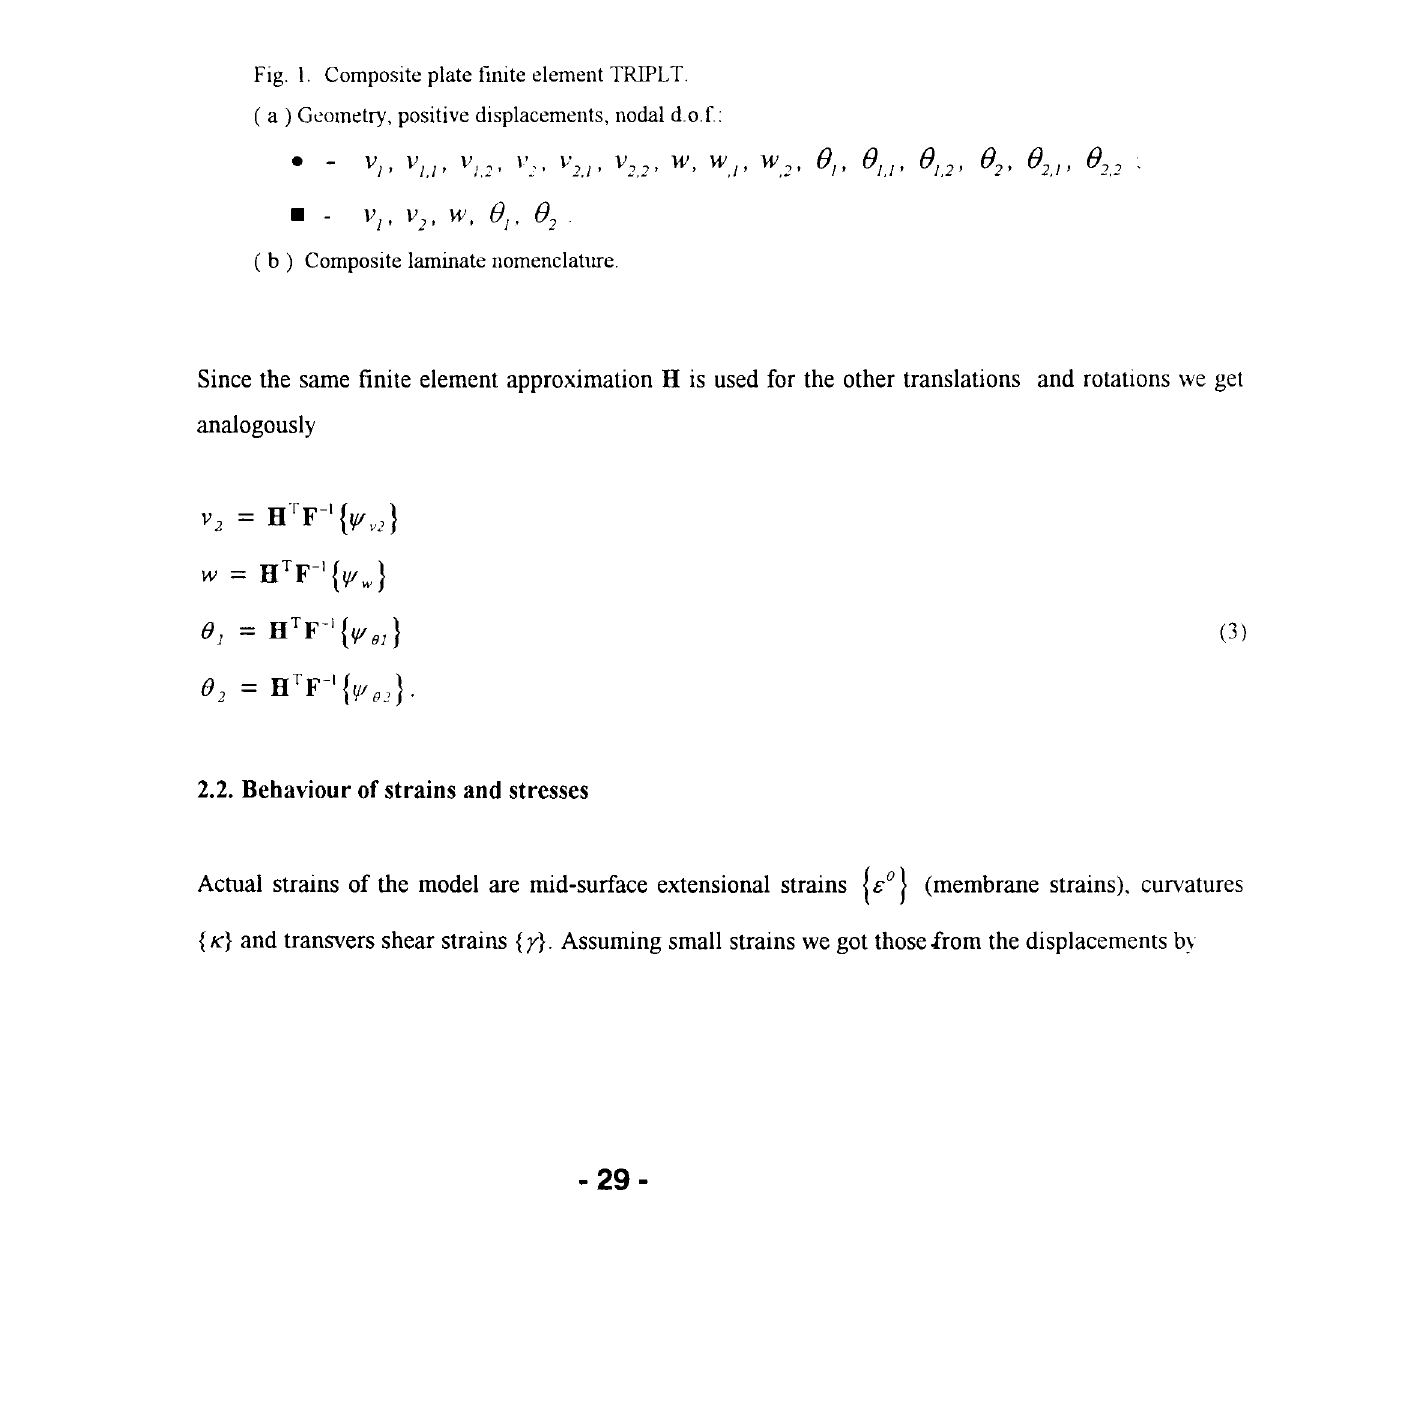
Fig. l. Composite plate tinite element TRIPL